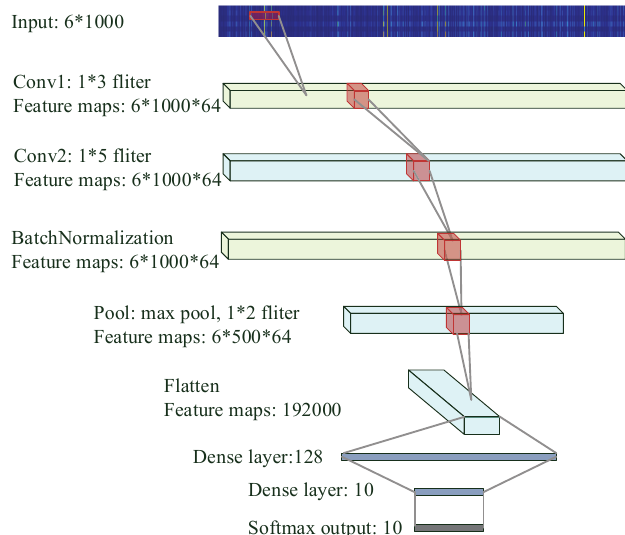
Figure 8. Convolutional Neural Network (CNN) architecture to decode silent